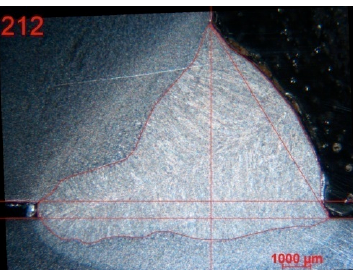
Fig. 16. Positive effect of small gap to penetration